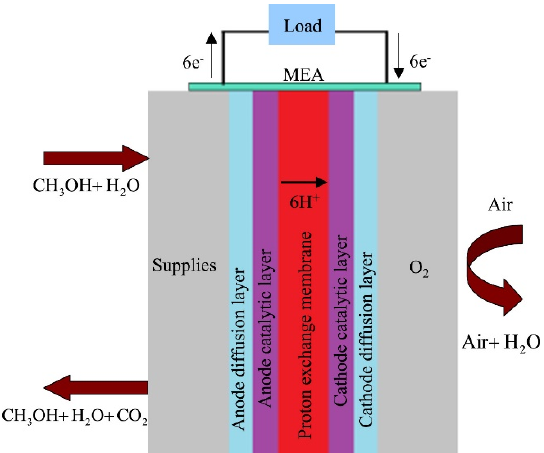
Figure 6. Scheme of the basic anatomy and functioning principle of a DMFC (reproduced from [199] with permission from Elsevier).